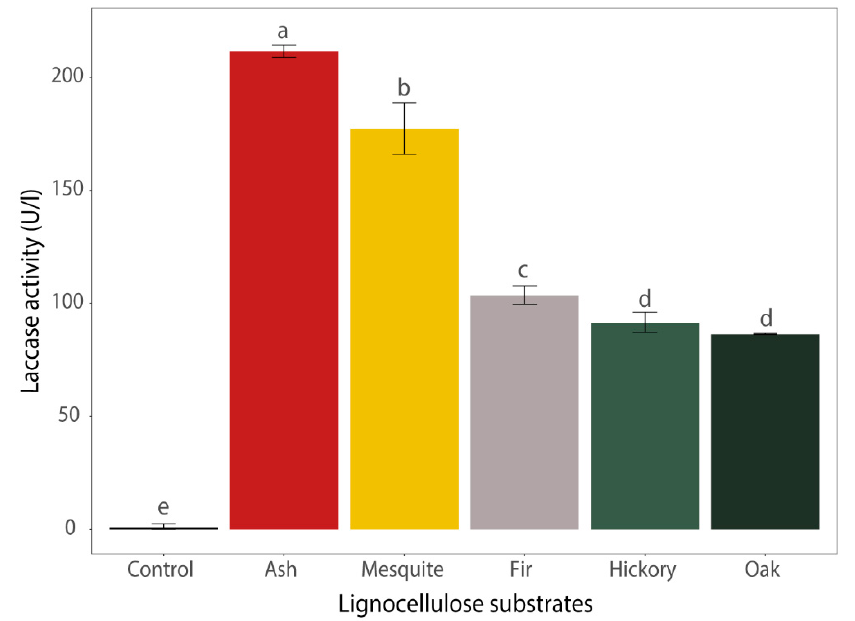
Figure 2. Laccase activity in culture supernatant incubated with various lignocellulose substrates. Ash, mesquite, fir, hickory, and oak were tested at 20 g L − 1 as sole carbon sources for laccase production. Significant di ff erences at p < 0.05 between the laccase activity were calculated using Duncan’s multiple range test.